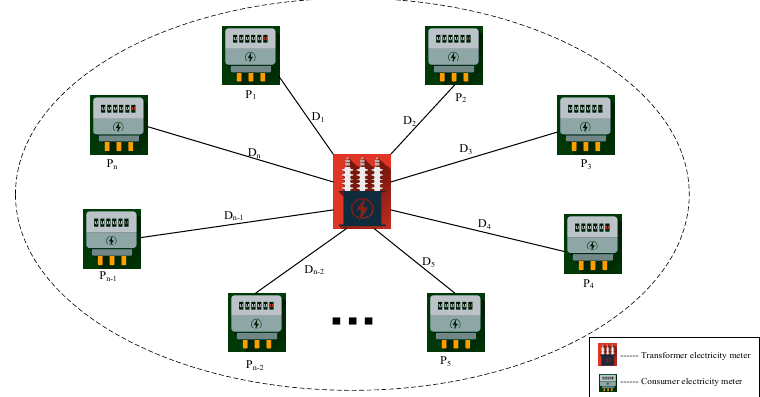
Figure 4. Schematic diagram of power supply torque.